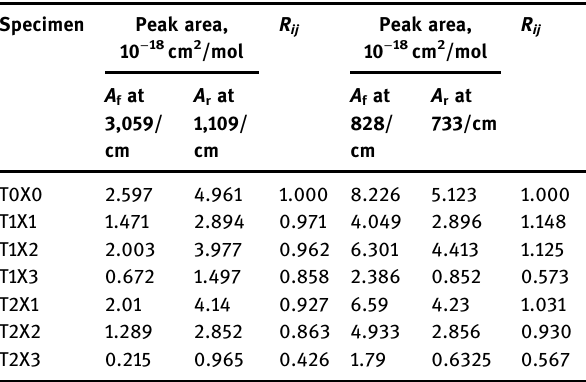
Table 4: Calculation of function group conversion of epoxy resin